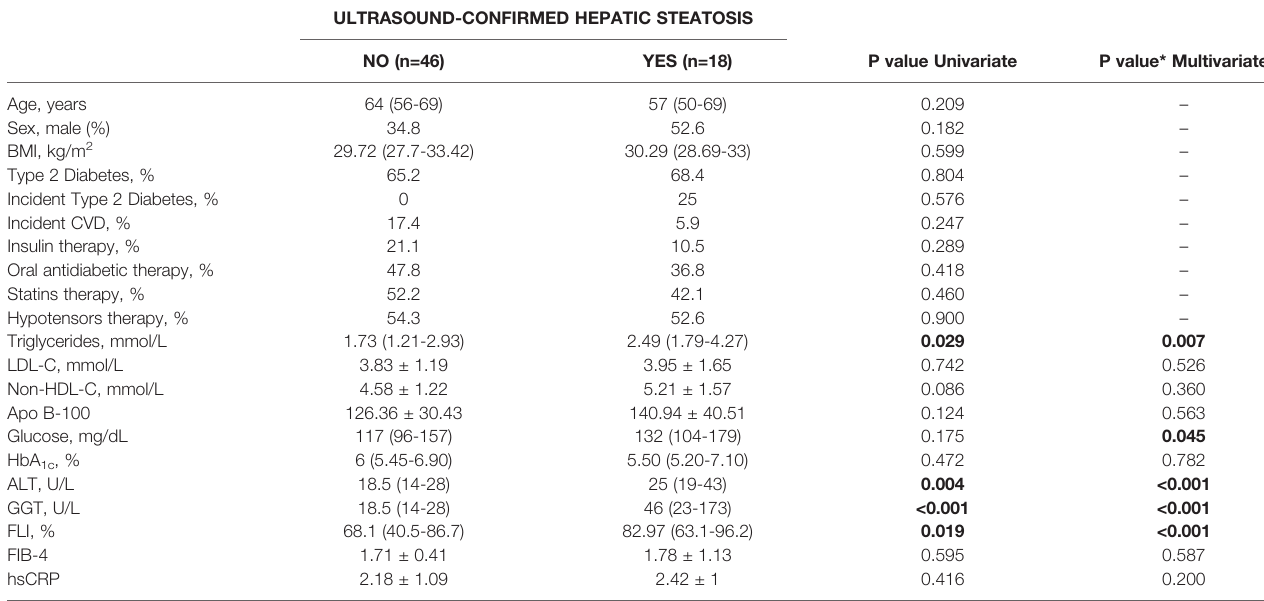
TABLE 4 | Baseline clinical and biochemical parameters of ultrasound-studied patients after a 10-year follow-up, grouped as disease-free (NO) or ultrasound-con fi rmed hepatic steatosis (YES). ULTRASOUND-CONFIRMED HEPATIC STEATOSIS